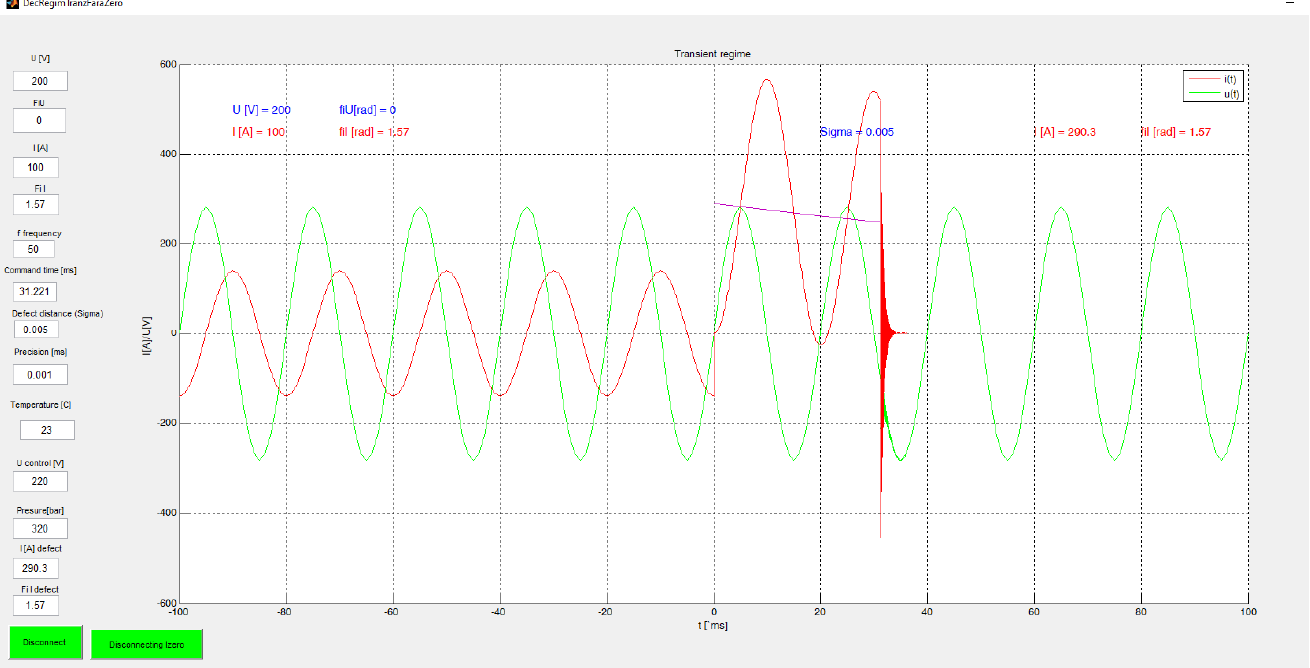
Figure 16. Transient uncontrolled switching diagram for inductive load, ɸ Idef = π /2, Idef = 290.3 A, σ = 0.005, t disconnect = 31.221 ms.